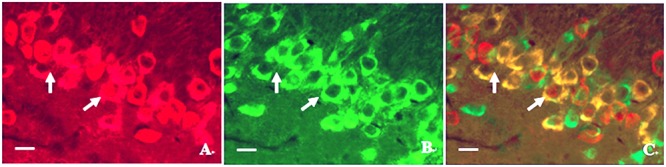
Photographs of relationship between the locations of calpain 1 and CaMK II proteins in hippocampus under a fluorescent microscope. (A) Calpain 1 positive cells; (B) CaMK II positive cells; (C) co-expressions of the two proteins under the same view (merged). Scale bar is 30 μm.